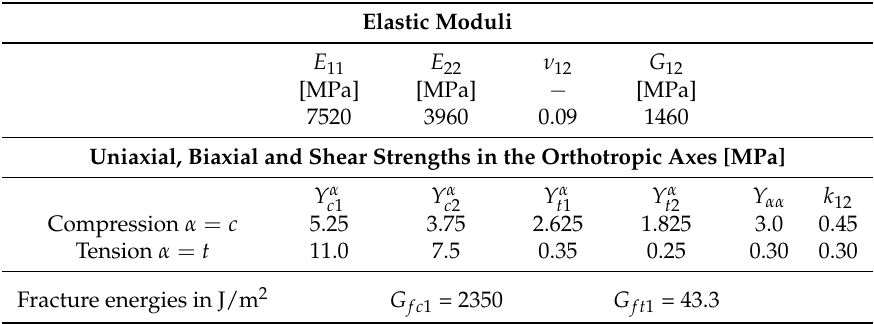
Table 3. Masonry shear wall. Material properties of the model.